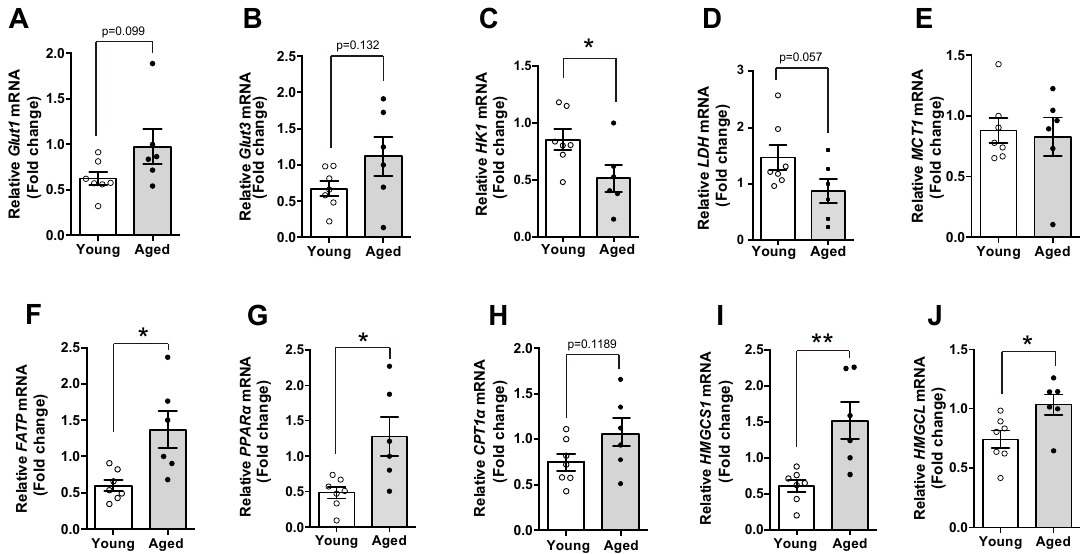
Figure 3. Aged mice display alternations in the expression of genes involved in cellular metabolism. mRNA expression in the hypothalamus of both young and aged C57BL/6 mice was analyzed. The mRNA levels of ( A ) glucose transporter-1 (Glut1) and ( B ) Glut3 were elevated in the hypothalamus of aged mice compared with young mice. Aged mice showed decreased levels of hypothalamic genes including ( C ) HK1 and ( D ) LDH . ( E ) No significant differences in hypothalamic MCT1 mRNA were observed between young and aged mice. The mRNA levels of ( F ) FATP , ( G ) PPAR- α , ( H ) CPT1 α , ( I ) HMGCS1 , and ( J ) HMGCL genes were increased in the hypothalami of the aged mice compared with young mice. Results are presented as mean ± SEM. n = 6–7 for each group. * p < 0.05, ** p < 0.01 for the aged group versus the young group.